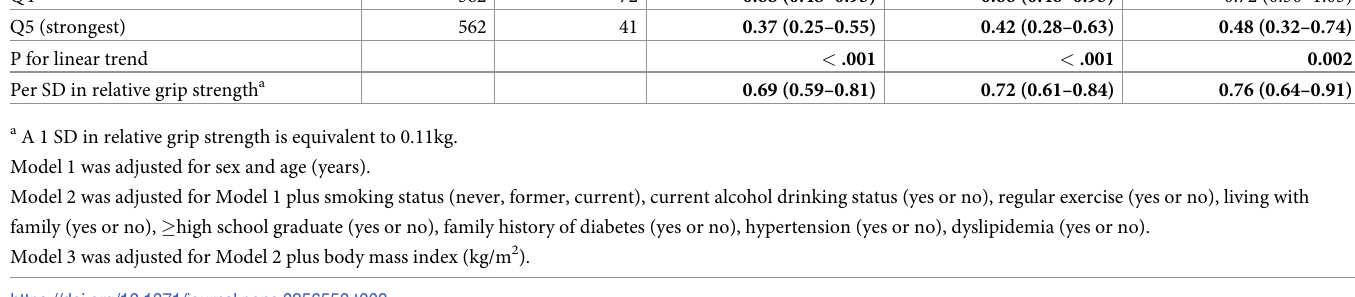
Compared to the lowest quintile of relative grip strength (weakest), the odds of T2DM were reduced in the upper four relative grip strength quintiles with ORs (95% CIs) of 0.75 (0.54–